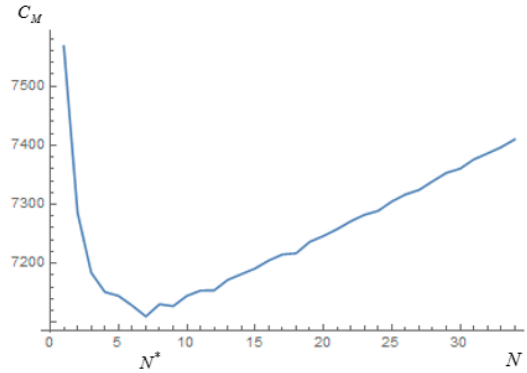
Figure 8. Total cost maintenance in function of preventive maintenance actions N .